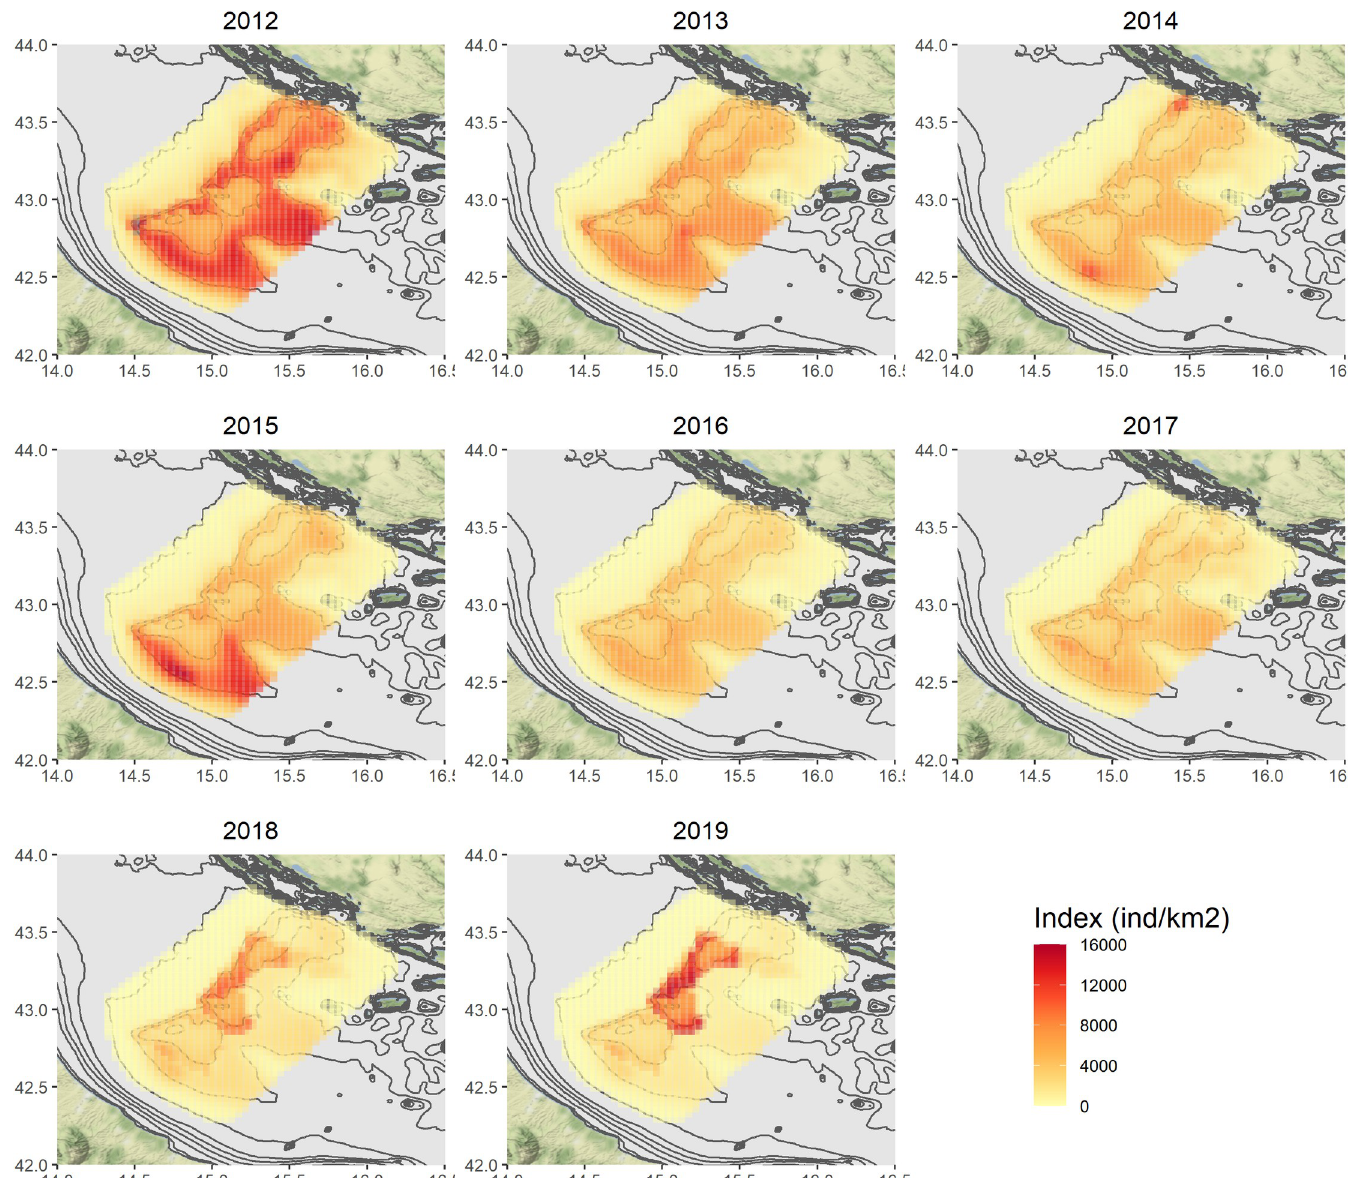
Fig 6. Predicted spatial distributions of Nephrops density index (N/km 2 ) for the spring time series. Maps were made using the ggmap package [108] for R. Bathymetry layer source: [75]. Map tiles by Stamen Design, under CC BY Data by OpenStreetMap, under